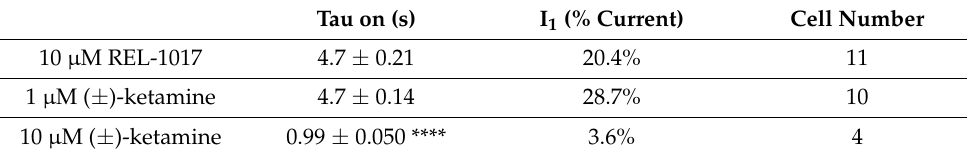
Figure 5. Sample traces of 10 µM REL-1017 and 1 µM (±)-ketamine onset and offset kinetics. Experiments were conducted by whole-cell patch-clamp electrophysiology at a − 70 mV holding potential in NR1-2C – expressing CHO cells. A protocol was established to measure how fast REL-1017 blockade of NMDAR-mediated currents can be established (onset kinetic) and how fast this blockade can be removed (offset kinetic) by perfusion with a buffer containing the agonist L-glutamate but devoid of REL-1017. Test item application protocol diagram (top) and sample traces (bottom) of test item onset and offset kinetic experiments are shown with 10 µM REL-1017-treated cell (left) or 1 µM (±)-ketamine – treated cell (right). I 0 , I 1, and I 2 were the currents measured at the end of the first 5 s of 10 μ M/10 μ M L-glutamate/glycine application, the 30-s co-application with test item, and the final 50-s co-agonists application, respectively. In this case, s is seconds. Table 4. Onset kinetic parameters.